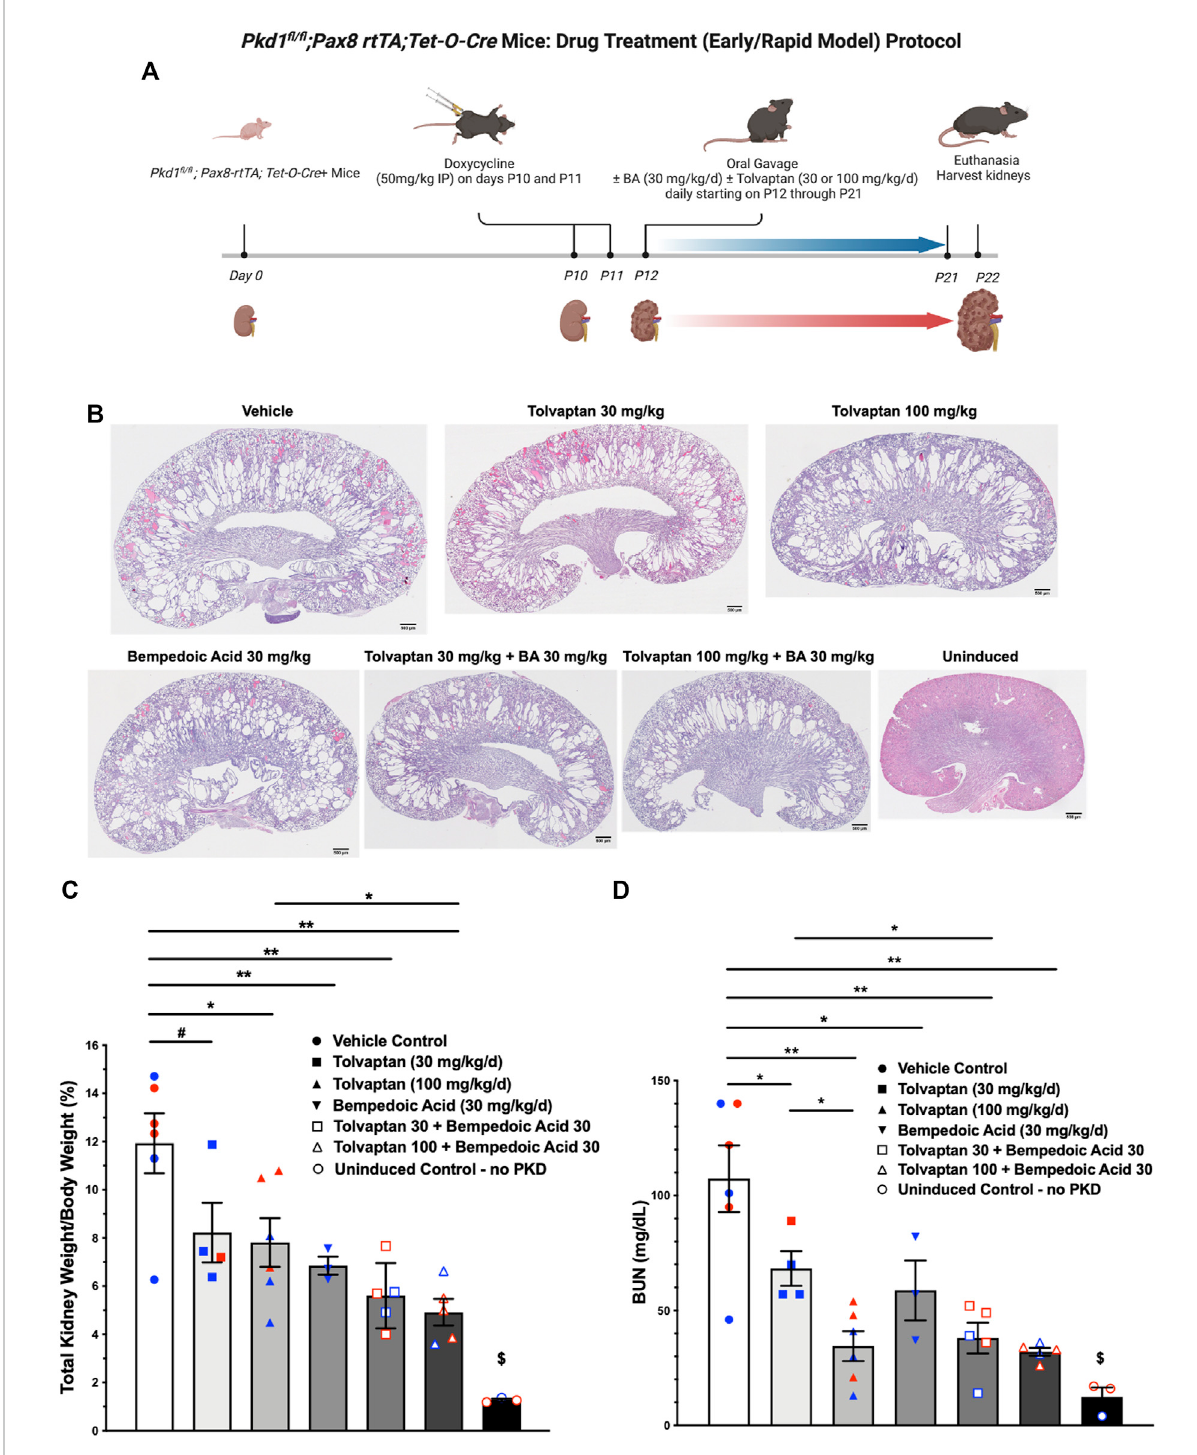
Bempedoic acid (BA) treatment alone and in combination with tolvaptan reduces PKD disease severity in an early/rapid induced Pkd1 gene inactivation ADPKD mouse model. As measures of disease severity in vivo , Pkd1 fl / fl ; Pax8-rtTA; Tet-O-Cre mice were induced with doxycycline to inactivate Pkd1 and then treated ± BA ± tolvaptan for 10 days prior to euthanasia, as shown schematically (A) , and then total kidney weight/body weight ratio (TKW/BW) and blood urea nitrogen (BUN) levels by iStat were evaluated as described in Materials and Methods. (B) Representative H&E-stained sagittal kidney sections under the different treatment conditions are shown. BA (30 mg/kg/d) reduced mean (±SE) TKW/BW (C) and